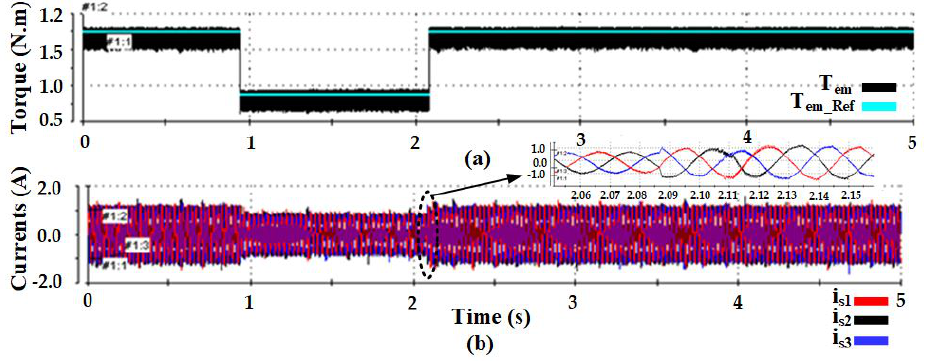
Figure 26. Experimental results of 6-sector DTRFC strategy: ( a ) torque response; and ( b ) three-phase